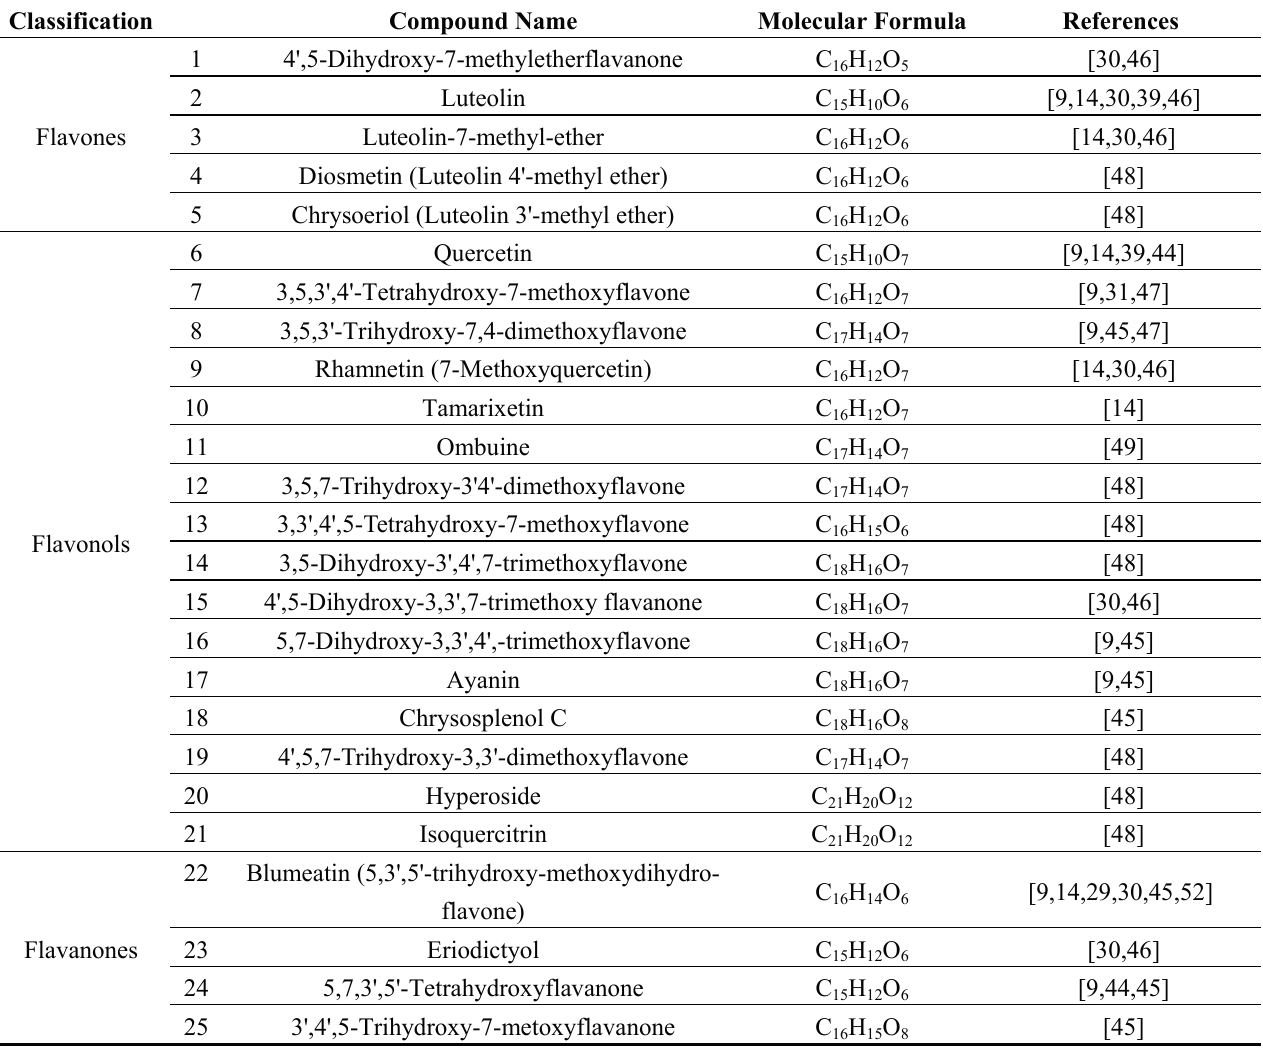
Table 2. The known non-volatile constituents of B. balsamifera